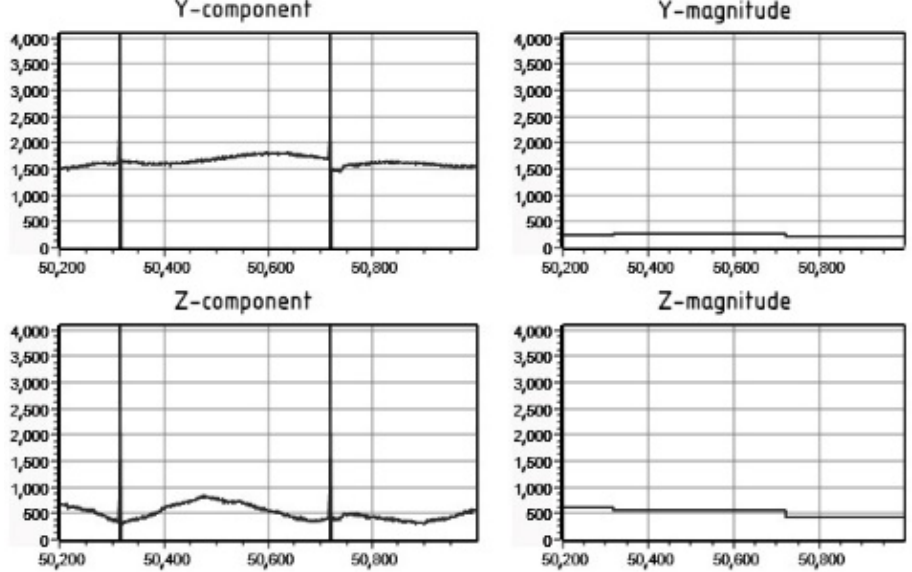
Figure 8. An oscillogram of the output signal of the ferroprobe ADC through the measuring channels of the Y- and Z-components when the cable is not energized (the background external field only). The horizontal axis is time and the vertical axis is the conventional units of the ADC output signal level.